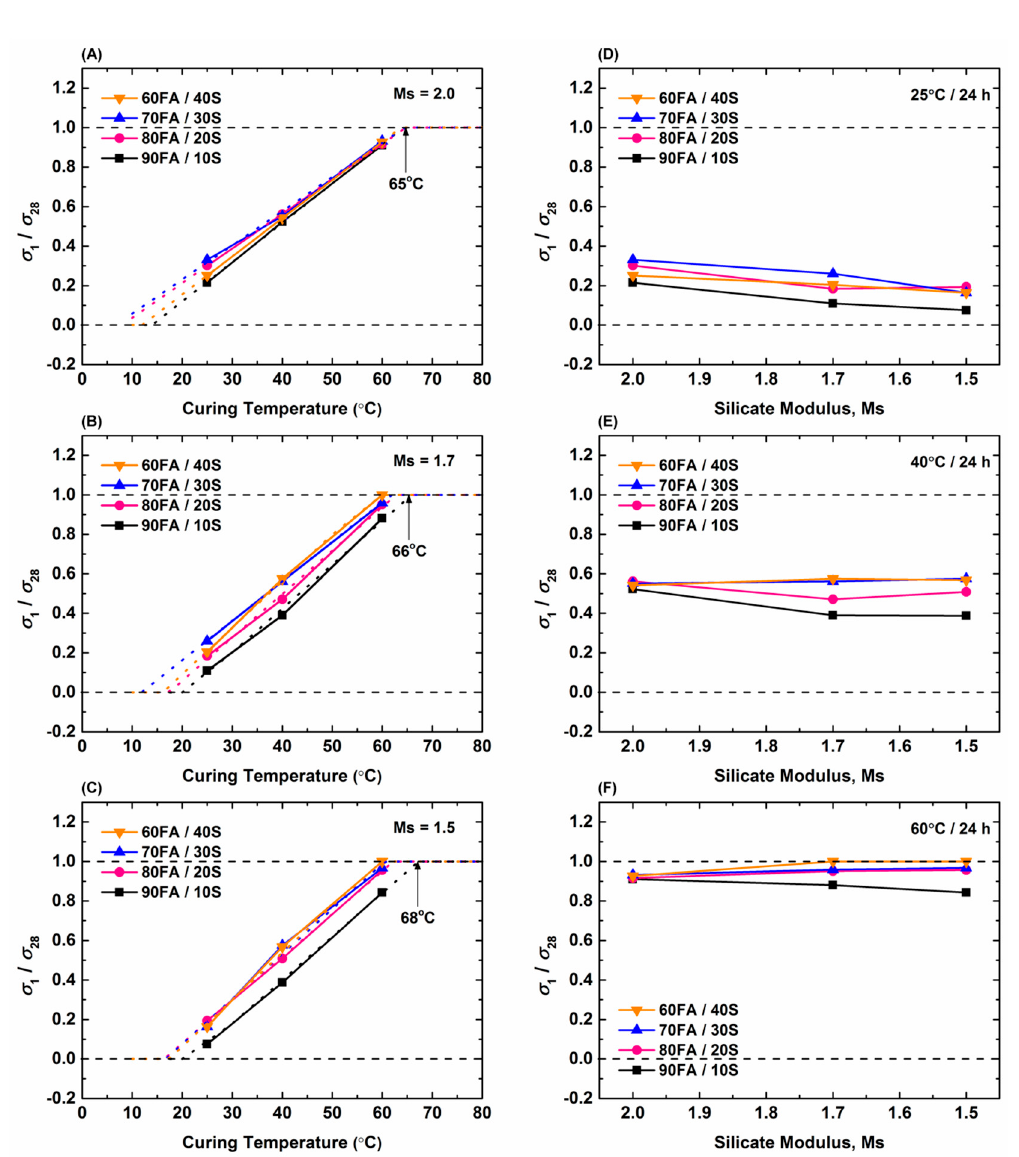
Figure 8. Ratio of 1-day to 28-day compressive strengths as a function of curing temperature, Ms value, and slag